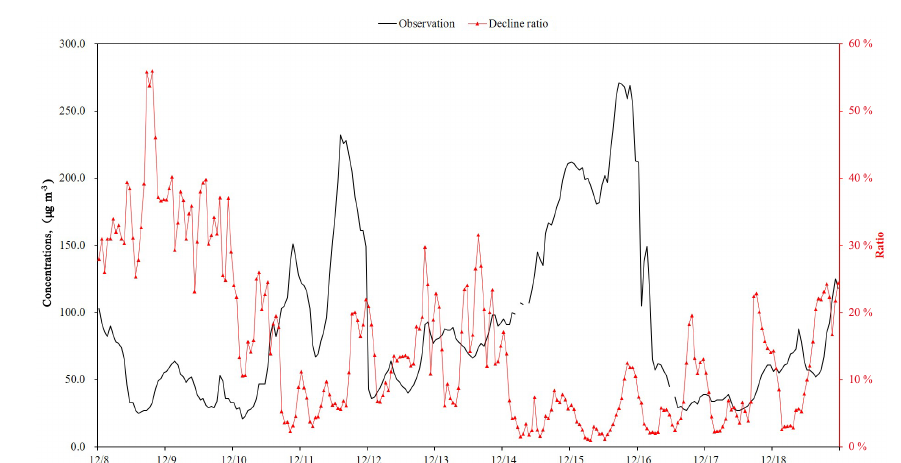
Figure 13. Time series of observed PM 2 . 5 and the percentage reduction resulting from the implementation of air quality control